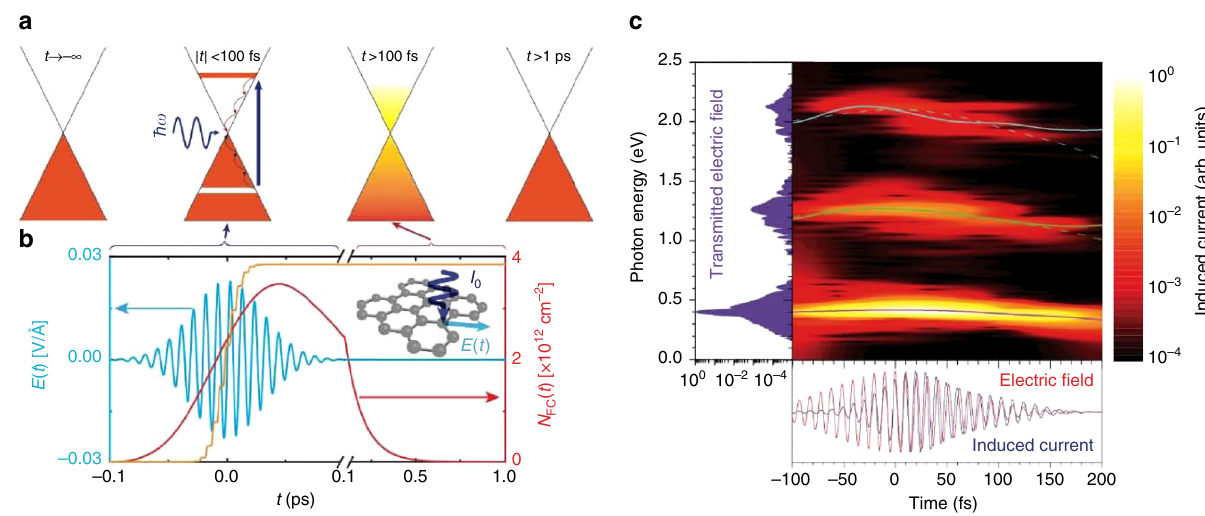
Fig. 1 Ultrafast response and dynamics of Dirac fermions. a Schematic representation of the ultrafast temporal dynamics of photoexcited electrons in extended graphene. b Temporal evolution of the free carrier density N FC (red curve, right vertical axis) generated by a normally-impinging linearly polarized Gaussian optical pulse (cyan curve, left axis) of 7 GW cm − 2 peak intensity and 50 fs FWHM duration, as obtained from the MDF model (see Methods) for monolayer graphene. A characteristic ionized fraction of an atomic gas target is shown for comparison as calculated with PPT theory 27 (orange curve). c Gabor analysis (150 fs Gaussian time window) of the squared induced current (color plot), along with the spectral (left plot) and temporal (lower plot) dependences of the transmitted electric fi eld. Solid curves superimposed onto the color plot correspond to the time-dependent spectral centroid of the fundamental and harmonic intensities, while the two dashed curves are obtained by multiplying the energy of the fundamental centroid by factors